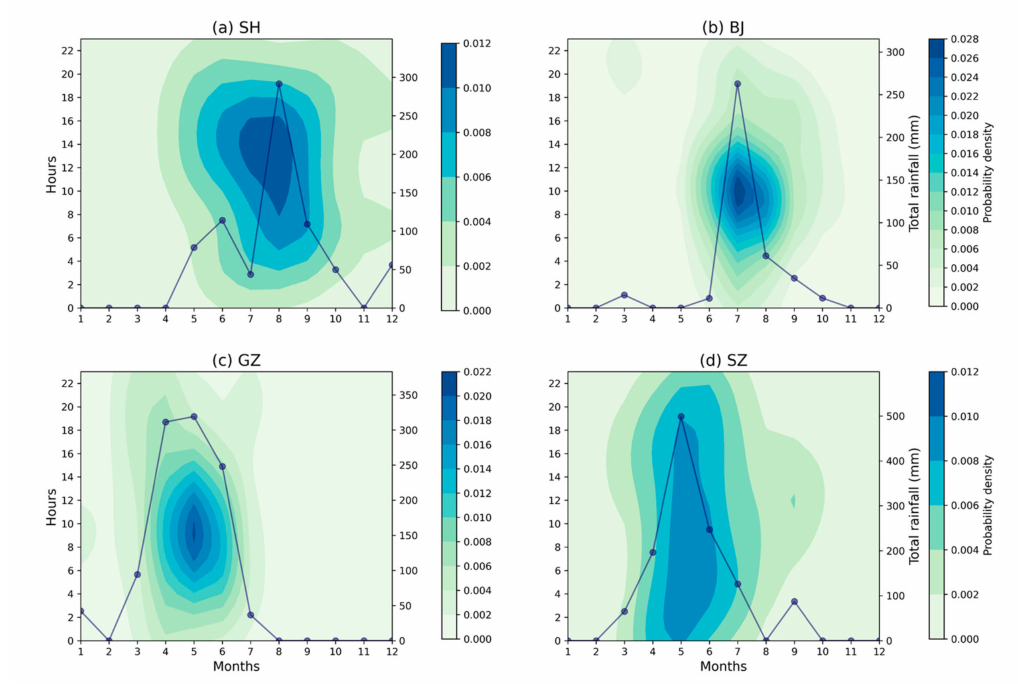
Figure 6. Diagram of probability density distribution to analyze the Rx3h occurrence (Point plots in figure means the total rainfall in months).